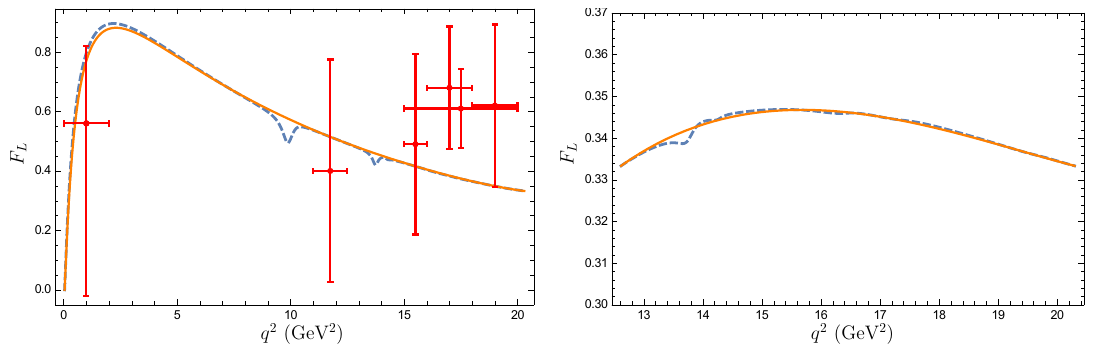
Figure 8. Predictions for the hadron forward-backward asymmetries A h Λ τ + τ ( left ) and Λ b − ( right ) rare decays. Notations are the same as in Figure 6. →